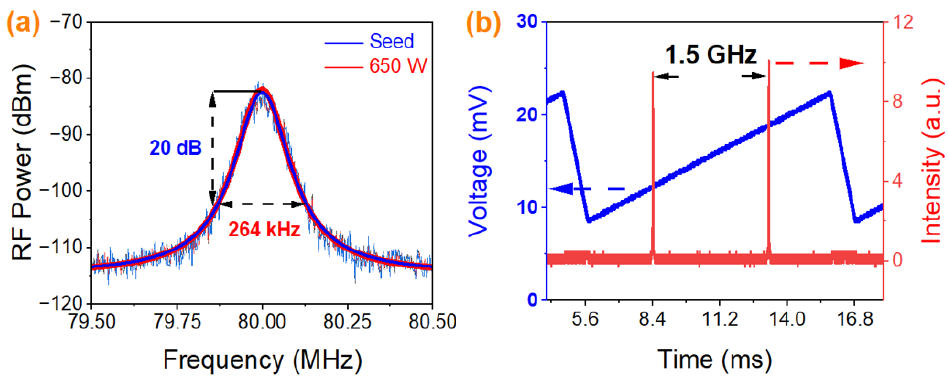
Figure 8. SFFA under hybrid pumping with a power ratio of 1:4.4. ( a ) Measured spectral linewidth of the seed laser and power amplifier at 650 W. ( b ) Measured longitudinal mode characteristics of the power amplifier at maximum output power.